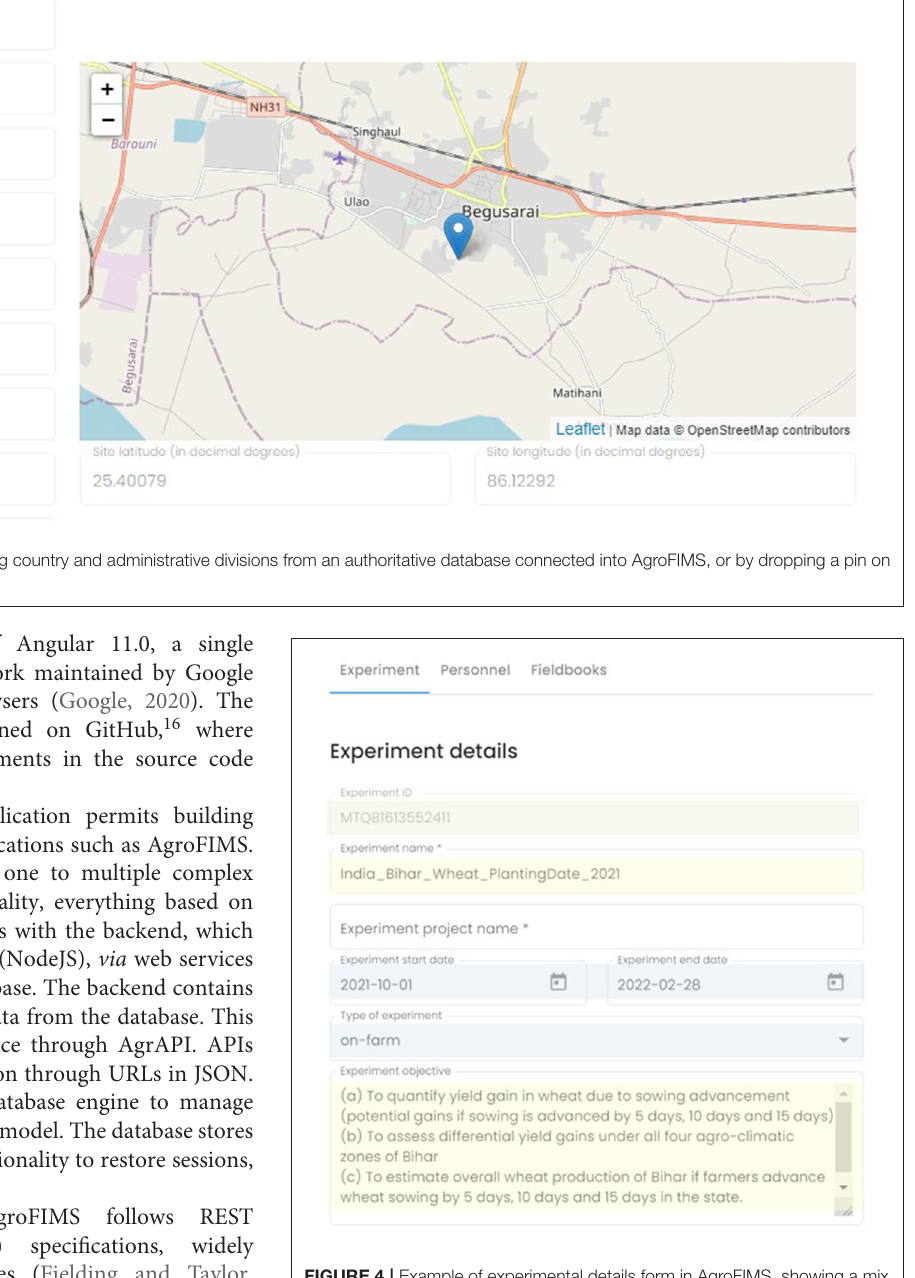
FIGURE 4 | Example of experimental details form in AgroFIMS, showing a mix of system-generated information (light green); standardized choices (light blue); and user-entered text (pale